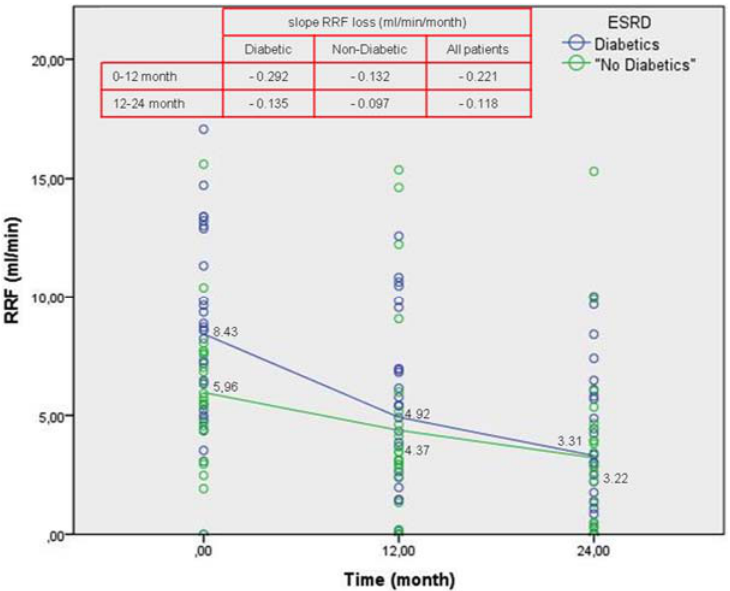
Figure 1. Residual Renal Function